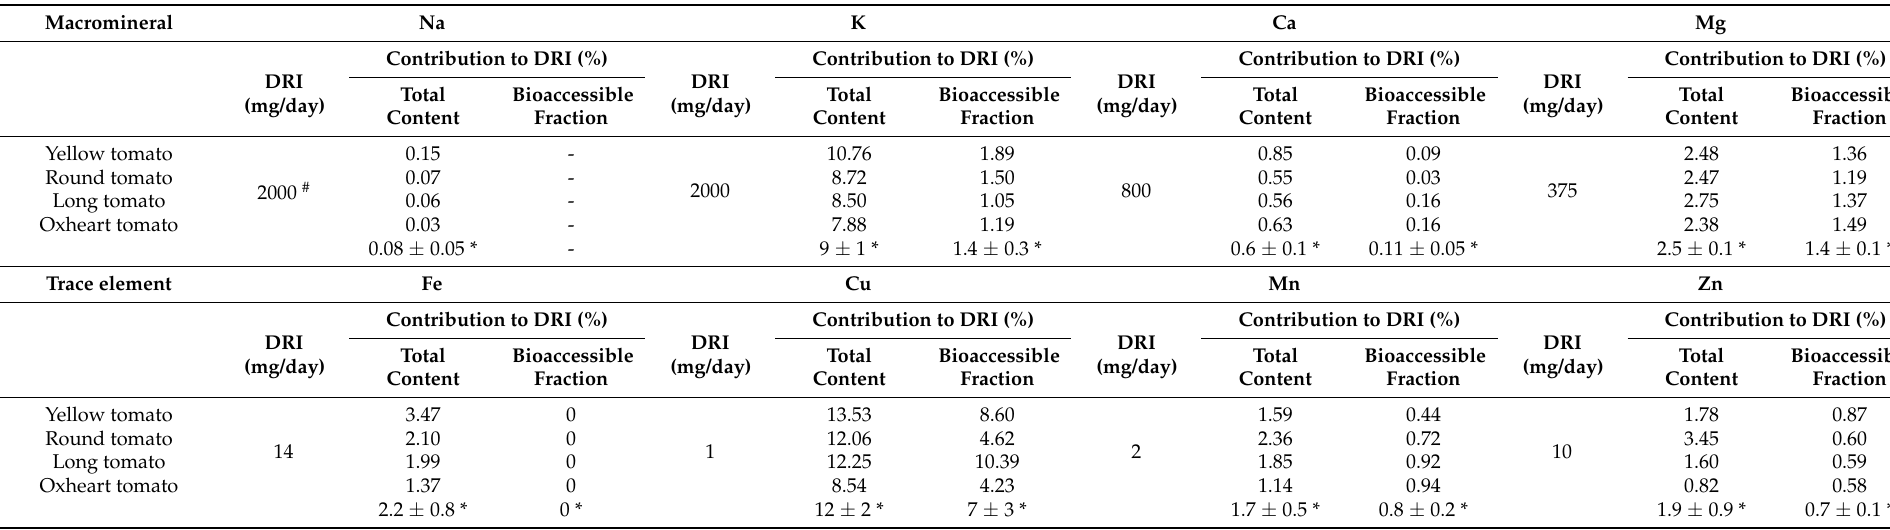
Table 3. Dietary reference intakes (DRIs) for minerals and contribution of the studied tomato farmers’ varieties (average per 100 g